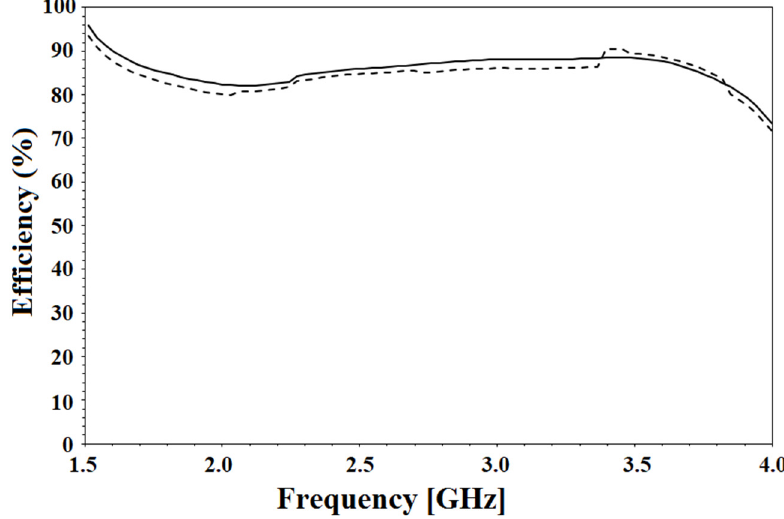
Figure 16. Measured and simulated efficiency of the proposed antenna.